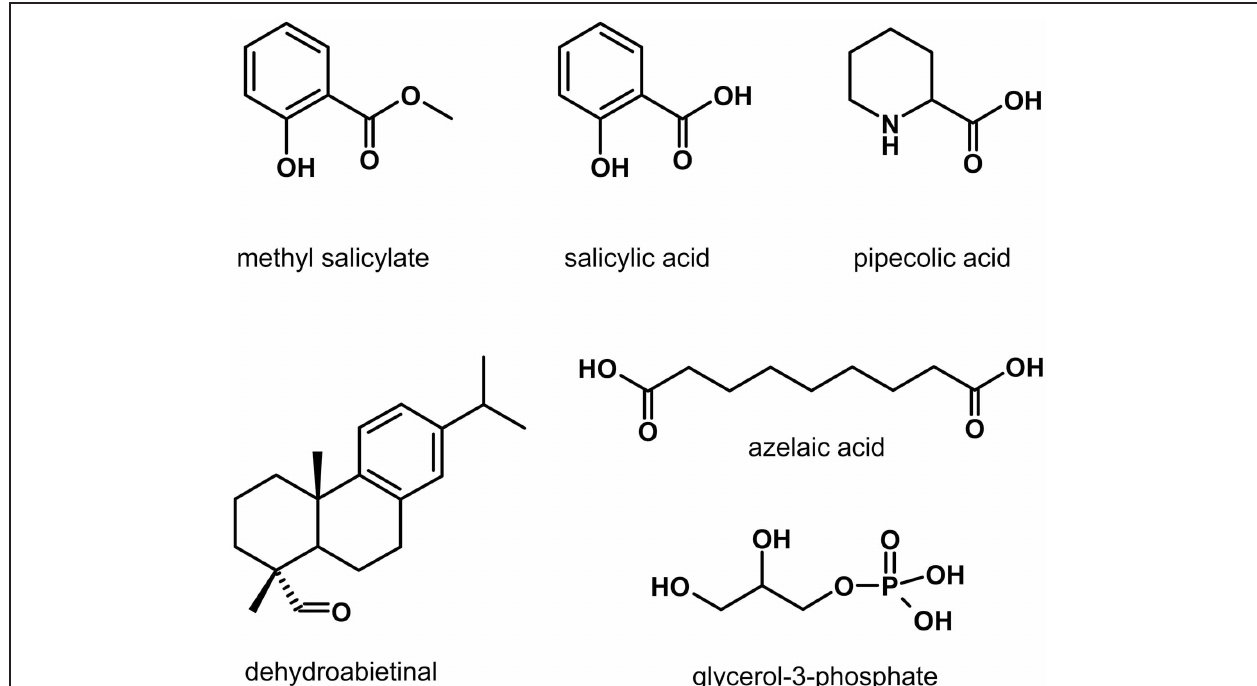
FIGURE 2 | Plant synthesized metabolites suggested to function in long-distance transport and/or signal amplification during systemic acquired resistance.